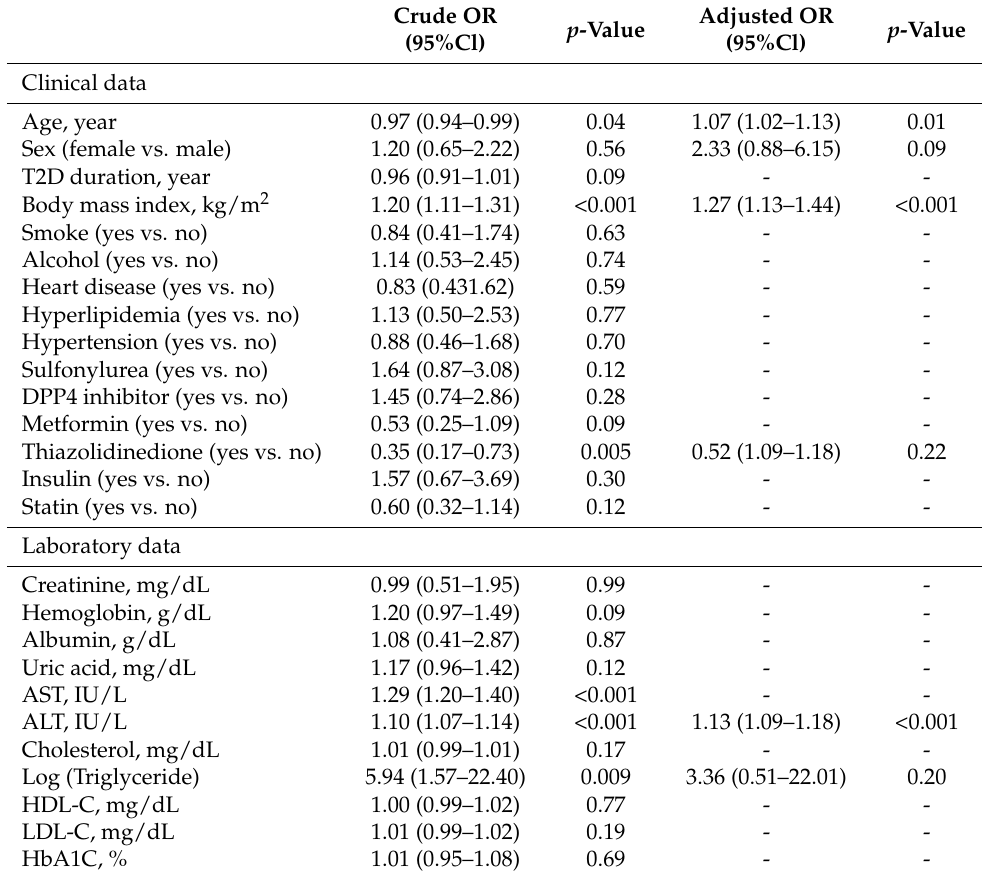
Table 4. Logistic regression of determinants of NASH risk (FAST score ≥ 0.35) in T2D patients with